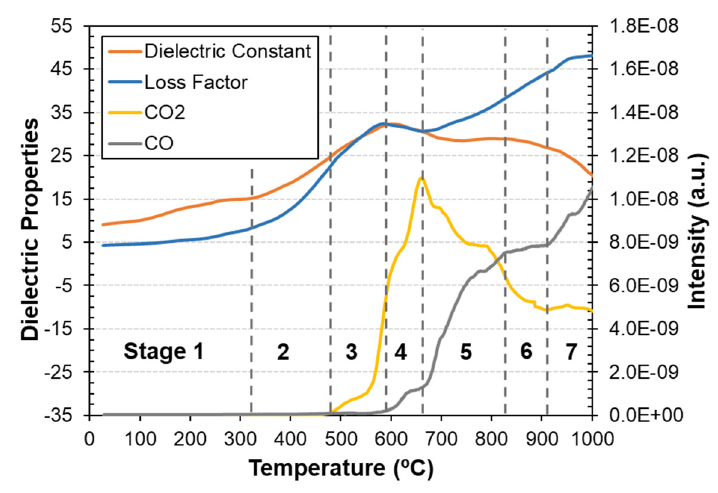
Figure 3. Dielectric properties and mass spectrometry (CO and CO 2 gases) of reference sample (C/O = 100%) as a function of temperature.